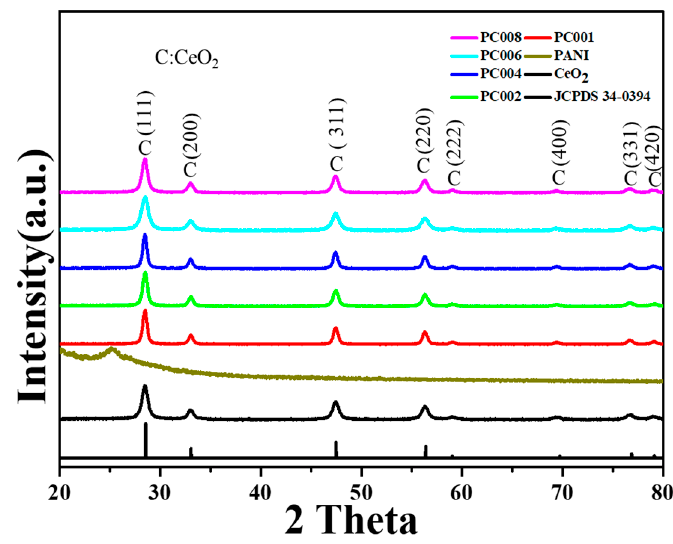
Figure 1. XRD pattern of the CeO 2 /PANI powders as a function of the amount of PANI coating.